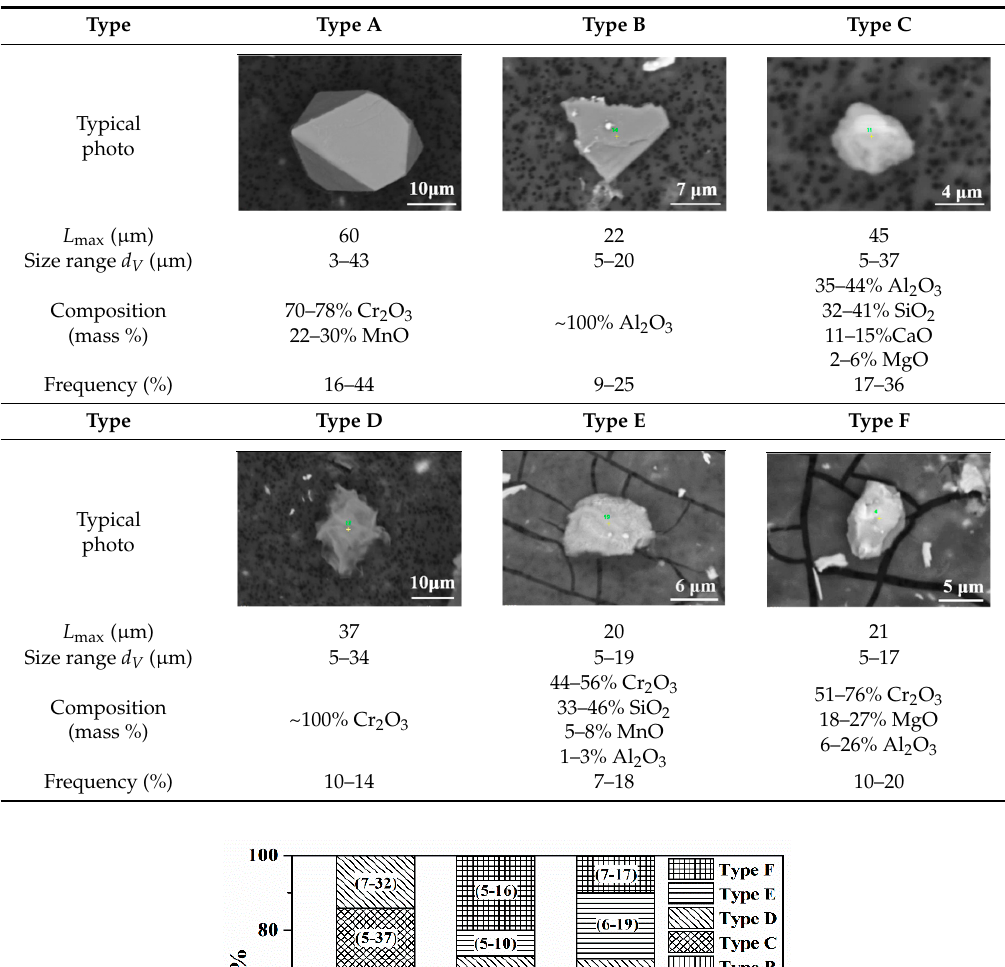
Table 5. Classification of inclusions in FeCr alloys.